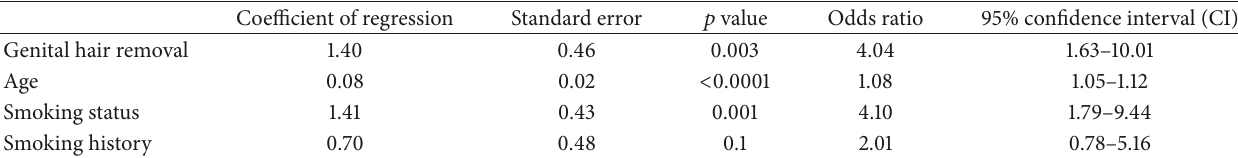
Table 2: Logistic regression for the development of vulva dysplasia/VIN according to hair removal adjusted for smoking status and age.